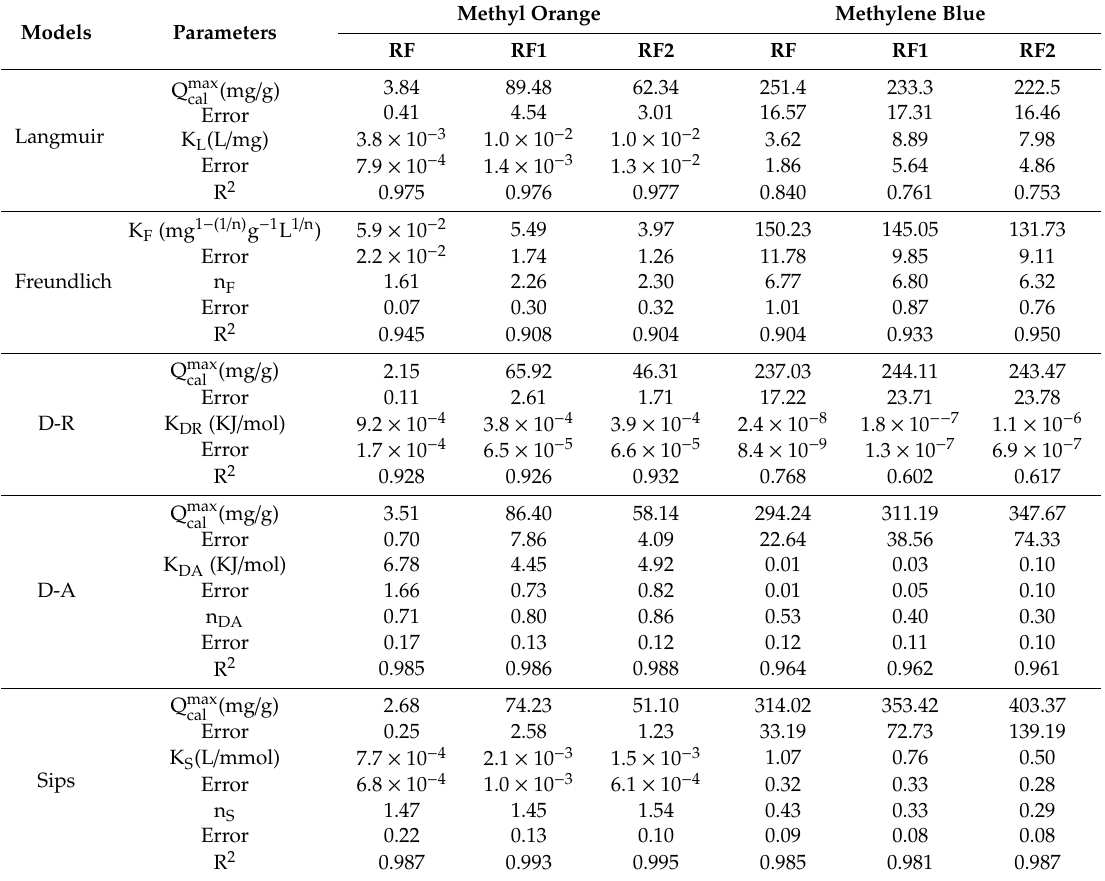
Table 3. Parameters of MO and MB adsorption